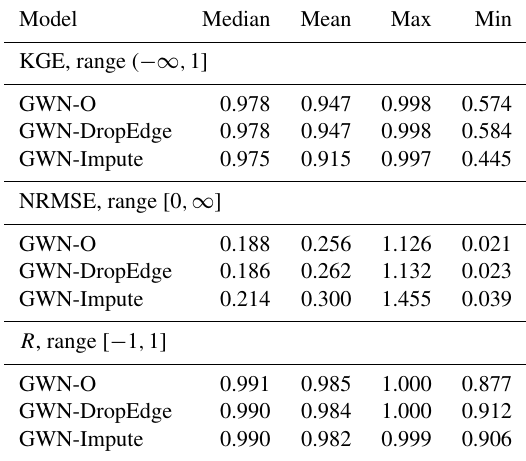
Table 1. Performance metrics of pretrained GraphWaveNet (GWN) surrogate models. GWN-O is the original model of Wu et al. (2019), GWN-DropEdge implements random edge sampling, GWN-Impute is trained on a subset of 23 nodes corresponding to the HUC-12 pour points. All results reported are based on ensemble averages from 10 models trained with different random